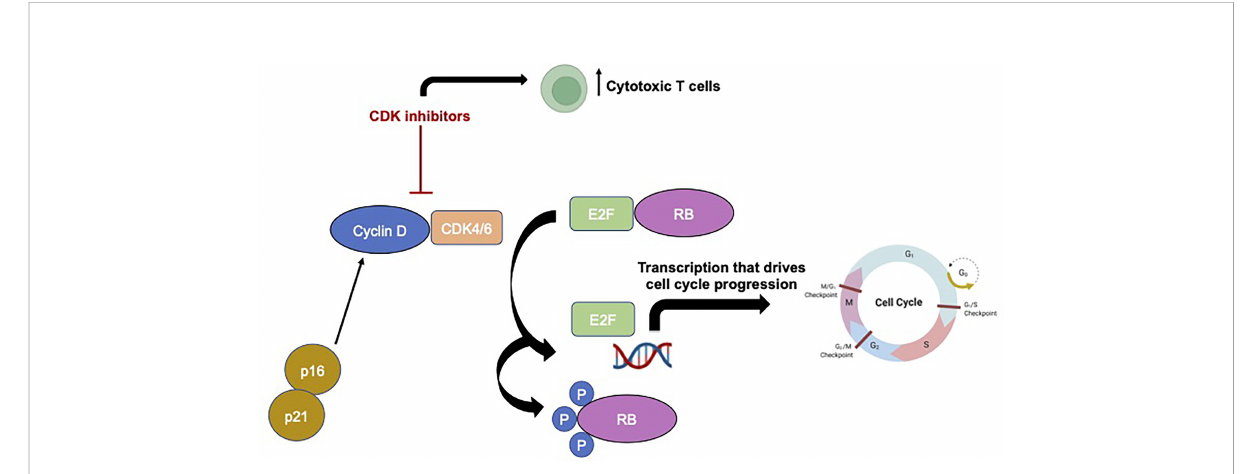
FIGURE 1 Schematic showing basic cyclin-CDK signaling pathway and mechanism of action of CDK inhibitors Made in